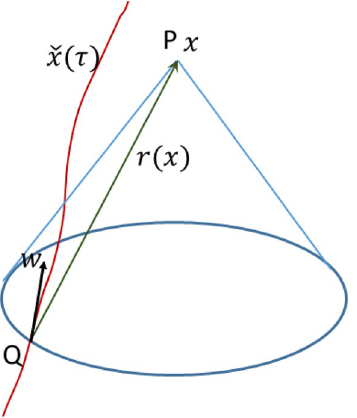
Figure 1. Two Lorentz covariant vector valued functions associated with a field of a single source moving along the world-line ˇ x (τ) . The point Q = ˇ x (τ( x )) is the intersection of the world-line with the backward light cone with vertex at P = x . The relative position null four-vector QP is r ( x ) = x − ˇ x (τ( x )) , and w (τ( x )) is the four- velocity at the retarded